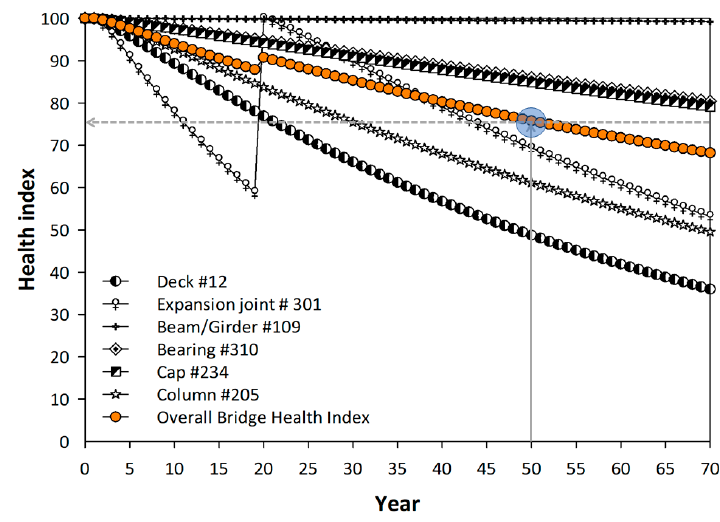
Figure 12. Effect of an Expansion Joint No. 301 Replacement (before applying the Co-Active approach).